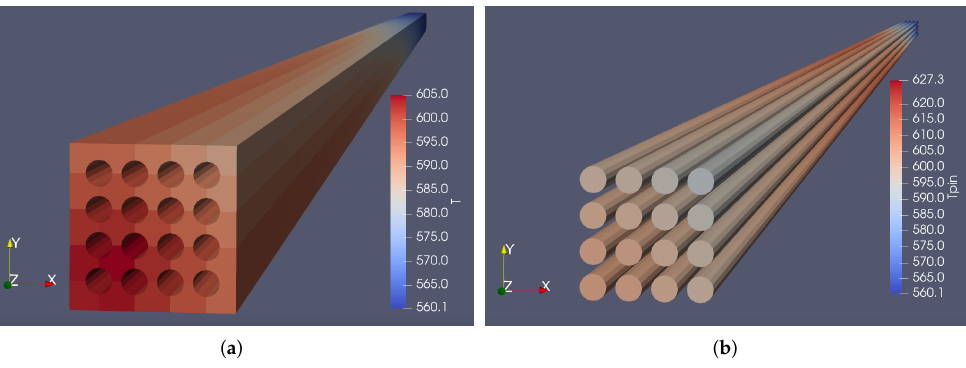
Figure 15. Code results for for the 4 × 4 PWR sub-assembly. ( a ) Subchannel temperature field for a non-uniform radial power profile. ( b ) Pin surface temperature field for a non-uniform radial power